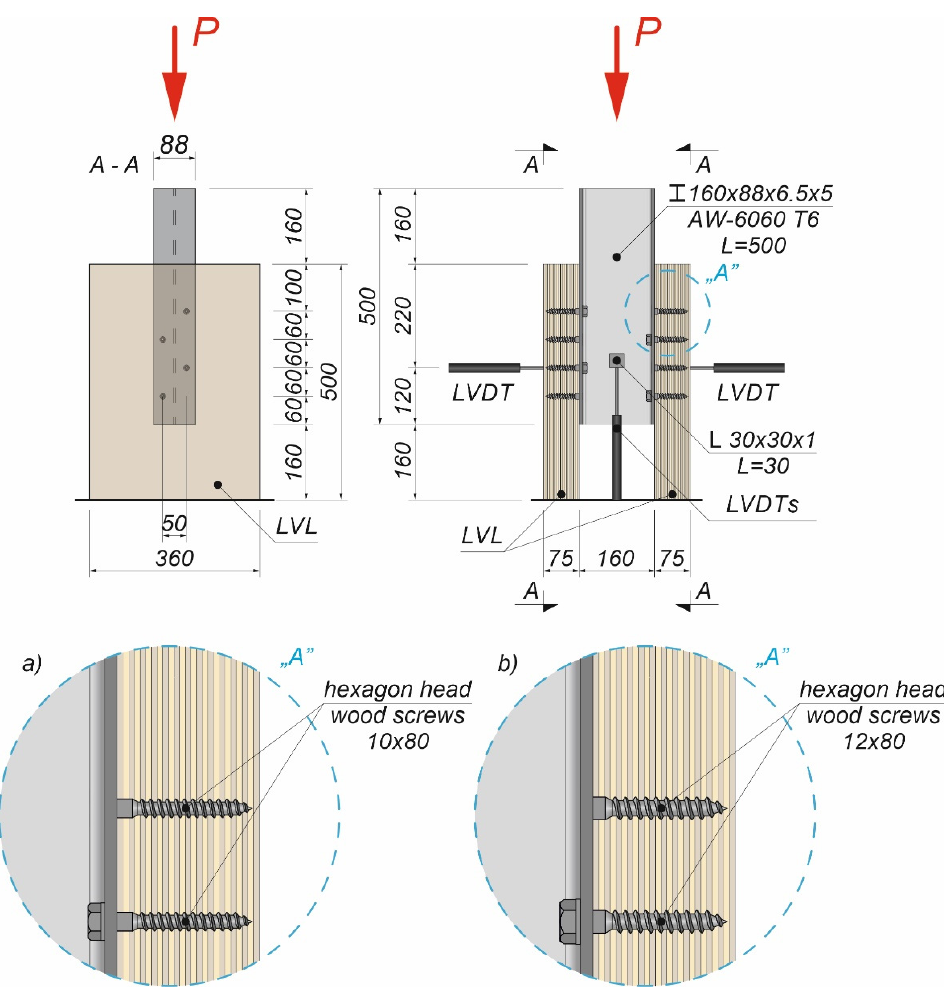
Figure 4. The location of the LVDTs on the specimen without reinforcing toothed plates: ( a ) screws 10 × 80; ( b ) screws 12 × 80.